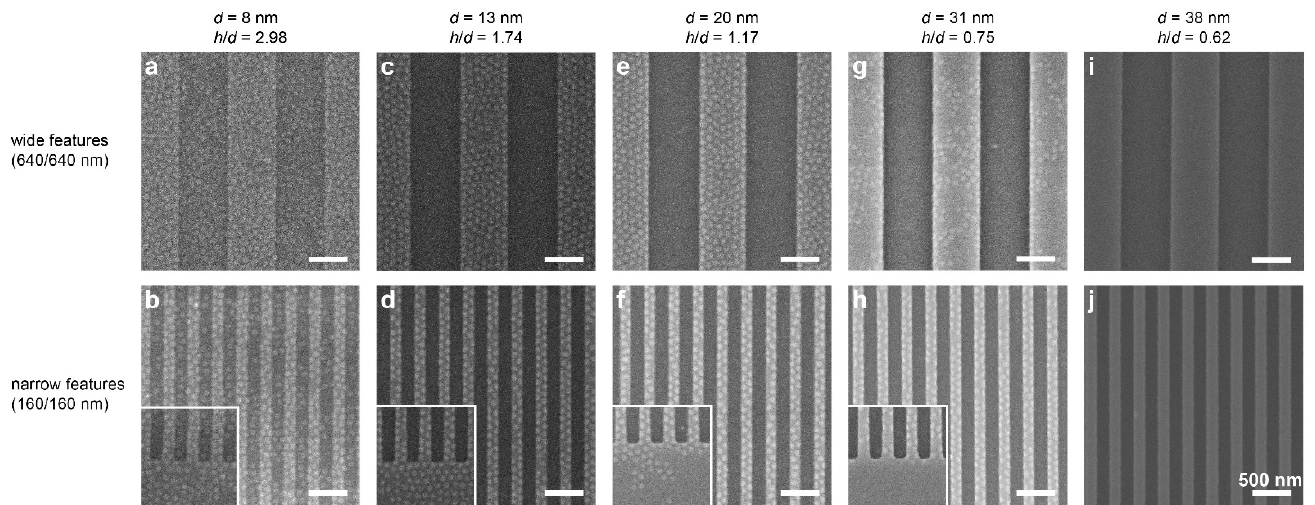
Figure 2. SEM images of substrates with 22–23 nm nominal (cast) film thicknesses on substrates of increasing trench depth: 8 ( a , b ), 13 ( c , d ), 20 ( e , f ), 31 ( g , h ), and 38 nm ( i , j ). The trench/plateau widths are 640/640 nm and 160/160 nm in the top and bottom row panels, respectively. Bright and dark stripes correspond to the plateaus and trenches, respectively. Insets show the border of the patterned area. All scale bars represent 500 nm. The images shown in panels ( c , f ) were adapted with permission from Ref. [36] (copyright 2019 American Chemical